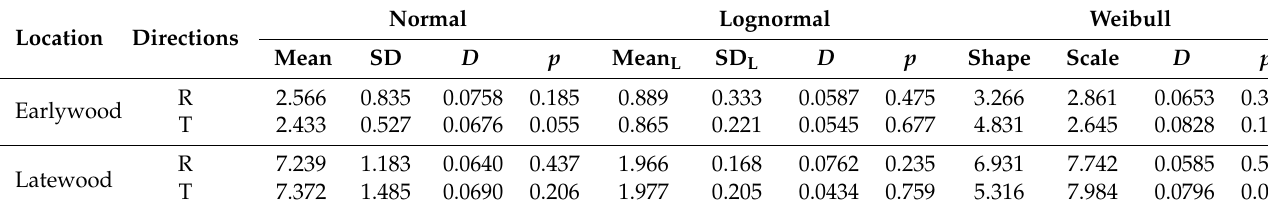
Table 1. Fitted parameters and KS test statistics (Unit: µ m).